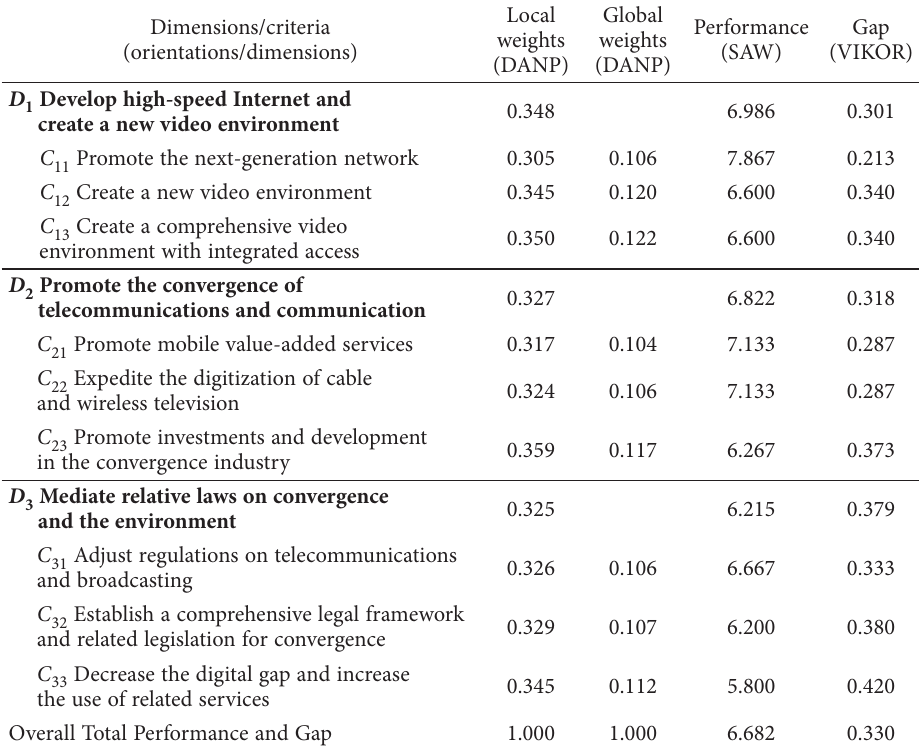
Table 13. Performance evaluation for the case